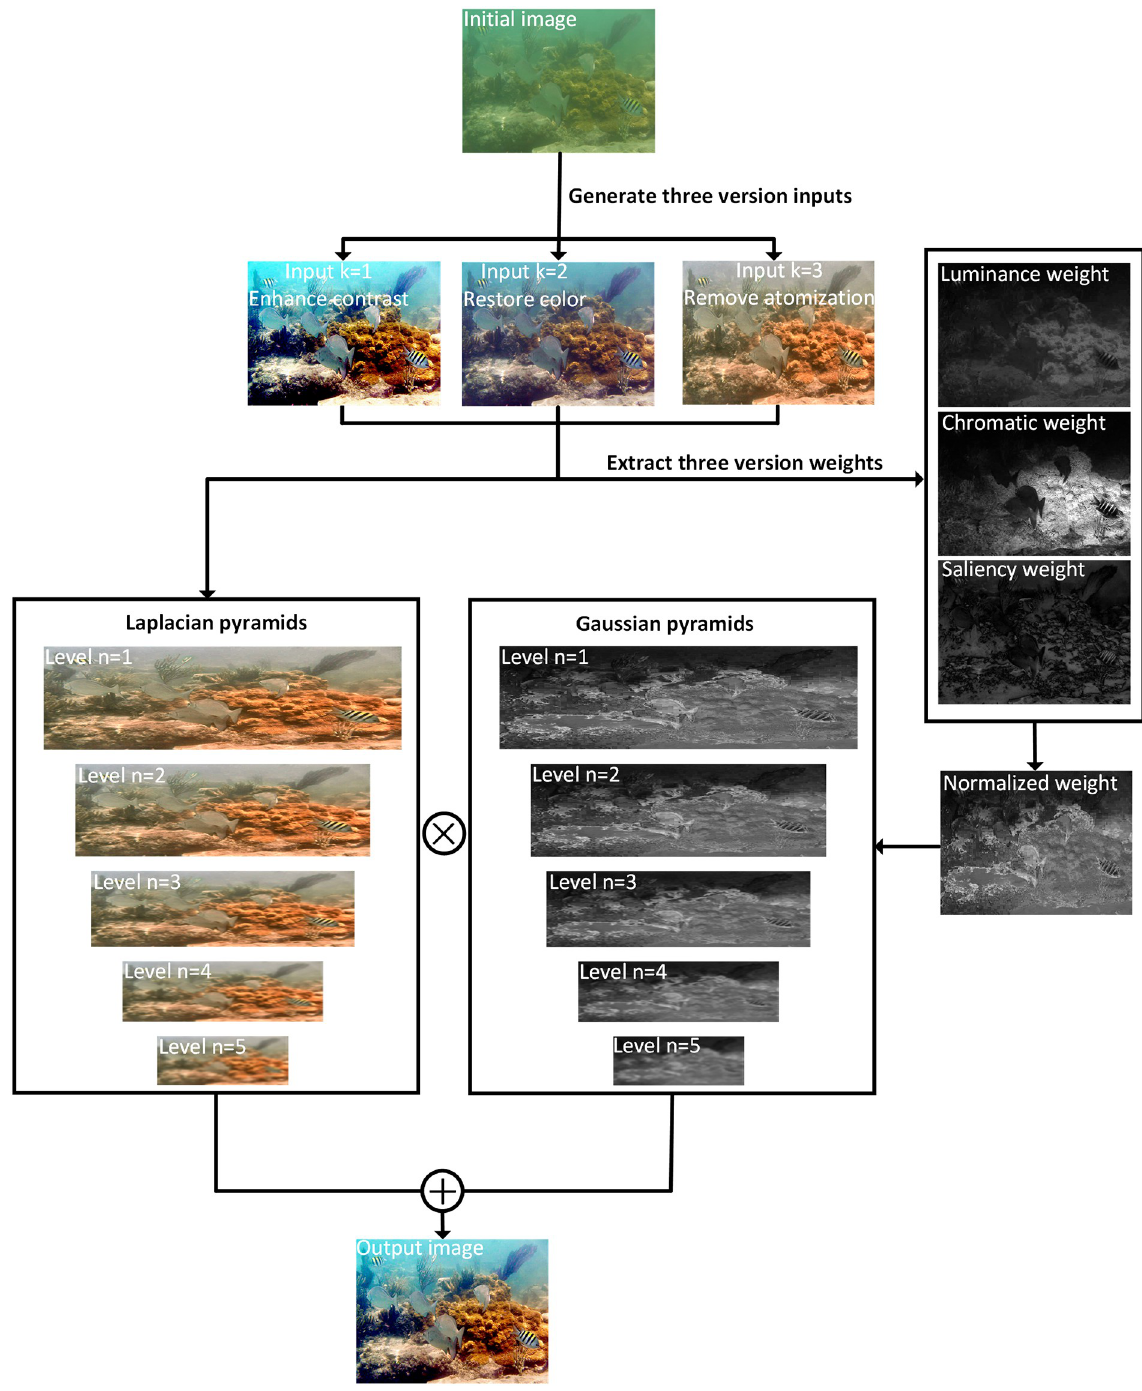
Fig 2. The three input images including contrast enhancement, color correction, and defogging are decomposed into five-layer Laplacian pyramids, respectively, and its normalized weight map is decomposed into five-layer Gaussian pyramids. (To simplify the flowchart, we only show the defogging weight map and its pyramid level decomposition in the figure). Finally, multi-scale fusion is performed to obtain the output image.